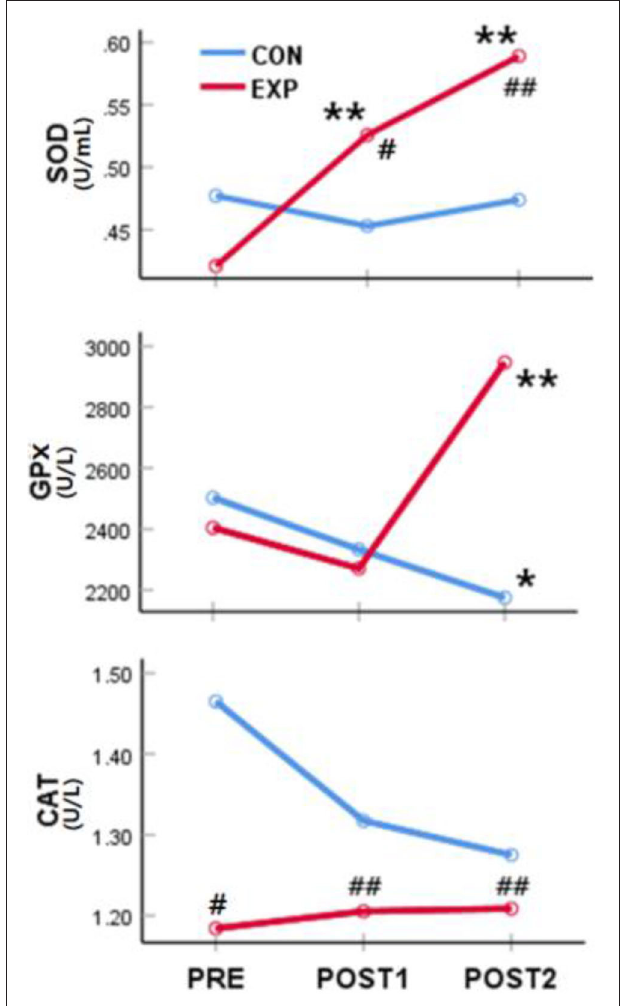
FIGURE 3 | Effect of the spinal thermal massage on antioxidant function. *significant difference from “PRE” values ( p < 0.05); **significant difference from “PRE” values ( p < 0.01); # significant difference from the control group ( p < 0.05). ## significant difference from the control group ( p < 0.01). PRE, pre-intervention; POST1, 4 weeks post-thermal massage treatment; POST2, 8 weeks post-thermal massage treatment; SOD, superoxide dismutase; GPx, glutathione-peroxidase; CAT, catalase; CON, control; EXP, experimental.